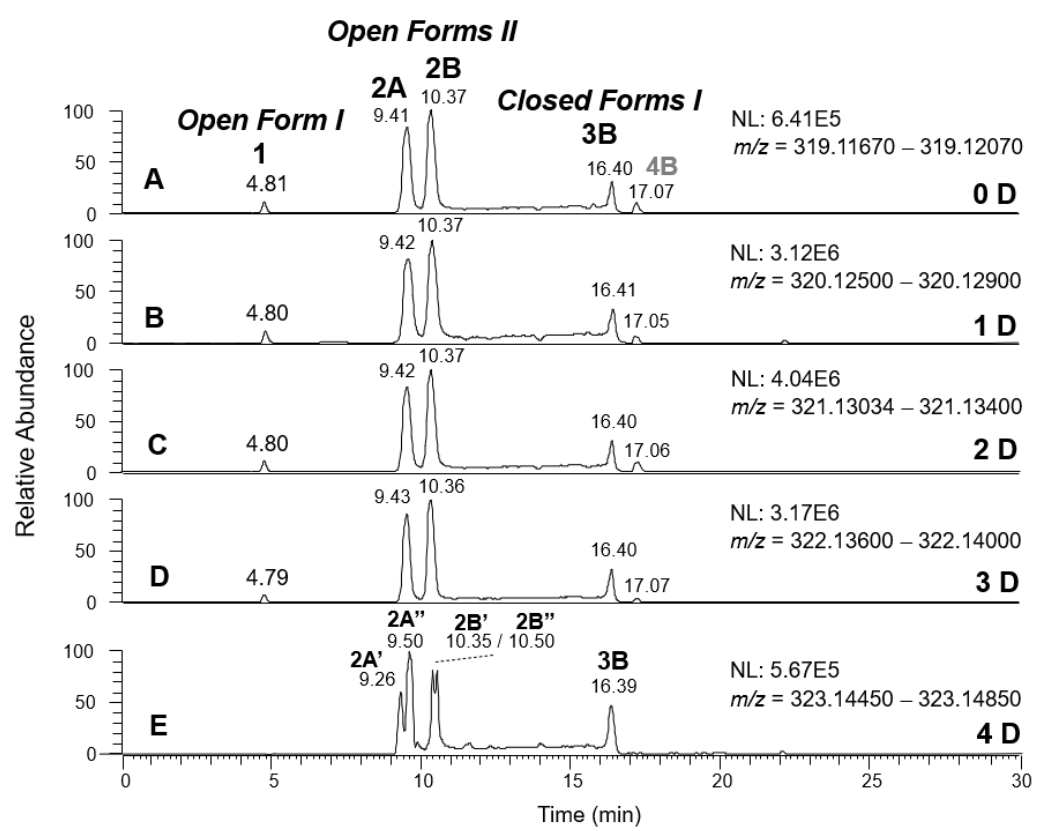
Figure 6. Comparison between XIC chromatograms obtained for the anions of non ‐ deuterated (0 D, panel A) and mono ‐ (1 D, panel B), bis ‐ (2 D, panel C), tris ‐ (3 D, panel D) and tetra ‐ (4 D, panel E) deuterated isoforms of OLEA, resulting from the HDX occurring during the RPLC ‐ ESI( ‐ ) ‐ FTMS analysis of an EVOO polar extract using D 2 O as co ‐ solvent of acetonitrile in the mobile phase. The m / z intervals adopted for the extraction of ion currents are reported along with the normalization levels (NL). The proposed structure for each isoform is depicted in Table 1. Peak 4B corresponds to the major isoform of oleocanthalic acid, formed upon oxidative degradation of OLEO and isomeric with OLEA (see text for details) Starting from dialdehydic Open Forms I and II and mono ‐ aldehydic Closed Forms I of OLEO (see the first row in the related part of Table 1), the single phenolic OH group is the only predictable site for H/D exchange, but it is also the site of negative ionization. Consequently, if the phenolic OH group is involved in the H/D exchange, the D atom is subsequently lost as a D + ion during the ESI process, and no deuteration can be finally observed for negatively charged OLEO (exact m / z value: 303.1238). Conversely, if the enolization of one of the suitable aldehydic groups occurs, the H atom of the resulting enolic OH group can be exchanged with D, and a negative ion with an exact m / z of 304.1301 is formed (see the second row in the OLEO section of Table 1). It is thus not surprising that peaks for all possible OLEO isoforms were detected in the XIC chromatograms referred to exact m / z values 303.1238 and 304.1301 (see Figure 5A,B), since all of them could include none or at least one D atom in the final ion. Notably, since peaks in the two XIC traces were well aligned in terms of retention times, the enolization leading to a D atom introduction in the deprotonated OLEO structure reasonably occurred during the ionization process in the ESI source.